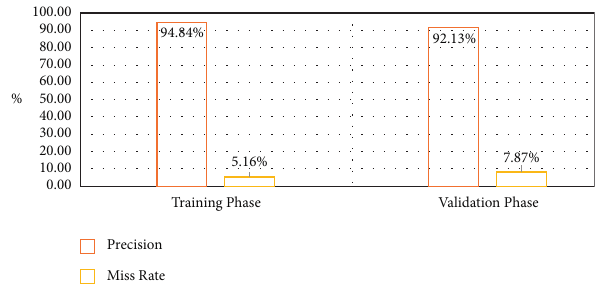
Figure 4: Overall performance of the proposed HDL2B-TUMOR-CLASSIFIER.